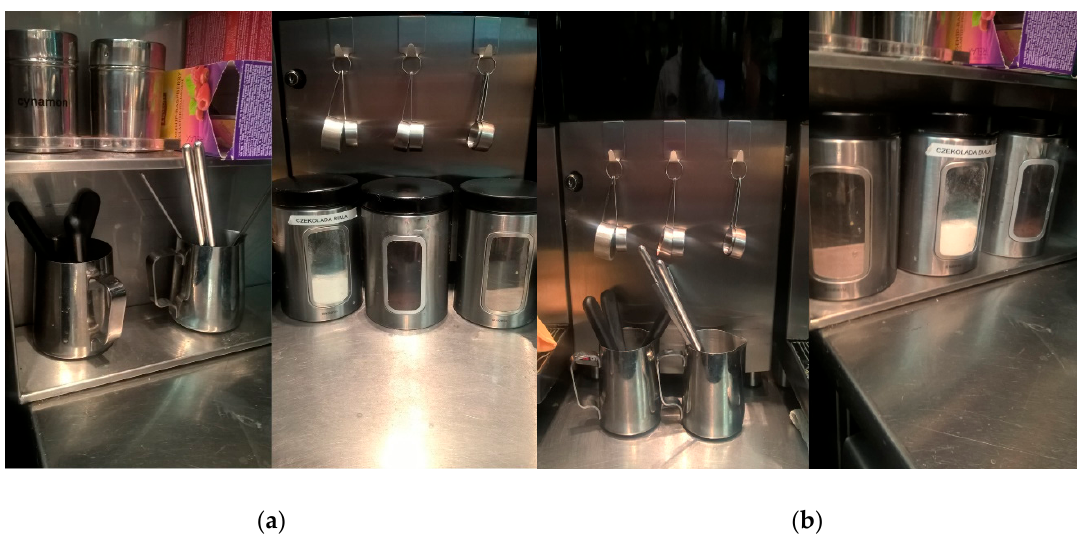
Figure 8. Settings for coffee sprinkles and drink finishing tools: ( a ) layout before the change; ( b ) layout after the changes.